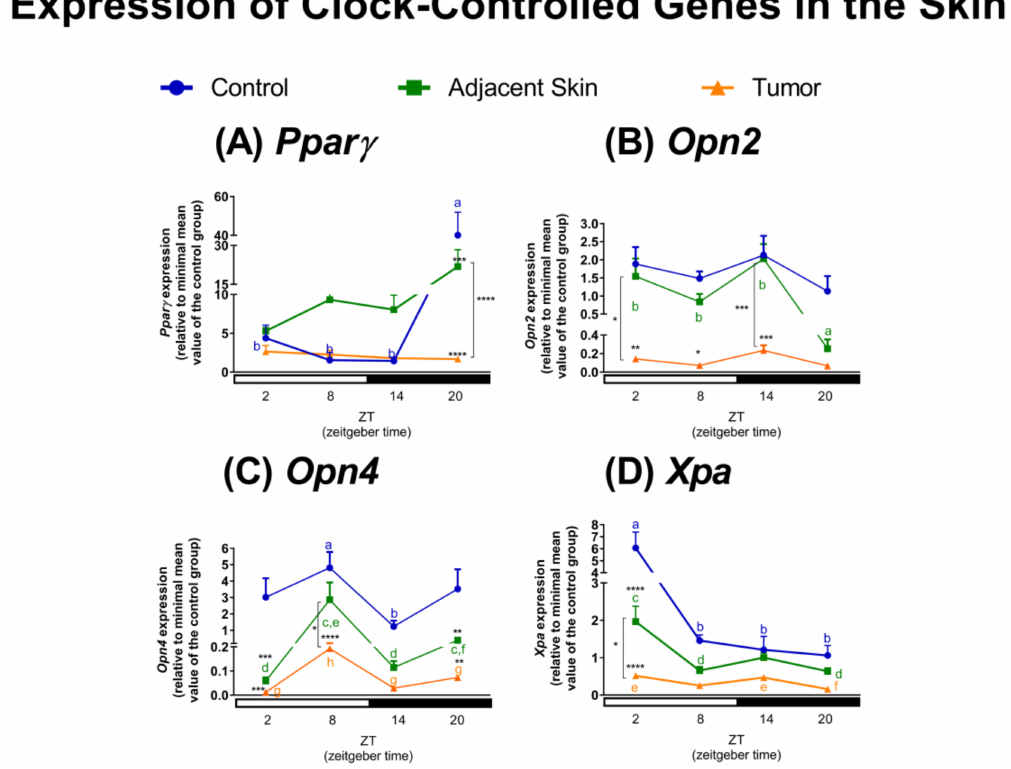
Figure 2. Non-metastatic skin melanoma affects clock-controlled gene expression in skin. Expression of ( A ) Ppar γ , ( B ) Opn2 , ( C ) Opn4 and ( D ) Xpa in control skin, tumor-adjacent skin, and tumor samples. Letters represent significant differences in gene expression within the same group, Two-Way ANOVA followed by Tukey post-test. In ( A ) a (cid:54) = b , p < 0.01. In ( B ) a (cid:54) = b , p < 0.01. In ( C ) a (cid:54) = b, p < 0.05, c (cid:54) = d, p < 0.0001, e (cid:54) = f, p < 0.05 and g (cid:54) = h, p < 0.01. In ( D ) a (cid:54) = b, p < 0.001, c (cid:54) = d, p < 0.01 and e (cid:54) = f, p < 0.05. Significant differences among groups were demonstrated by Two-Way ANOVA followed by Bonferroni post-test, and are represented by asterisks having the control skin as reference. Differences between tumor-adjacent skin and tumor samples are indicated by brackets. * p < 0.05, ** p < 0.01, *** p < 0.001, **** p < 0.0001. Values are presented as the mean expression ( n = 3–7) ± SEM of the gene of interest normalized by Rpl37a RNA, relative to the minimal value of skin control